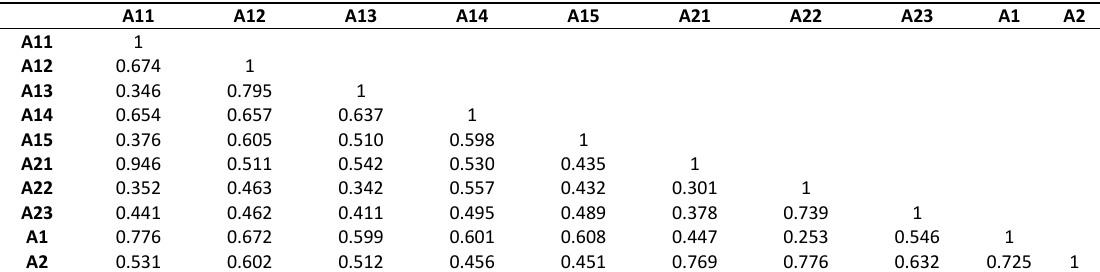
Table 3: Correlation between the indicators and the constructs